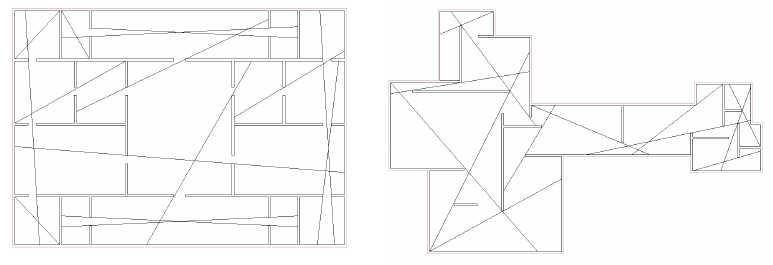
Table 1. Computation time of the sample cases.